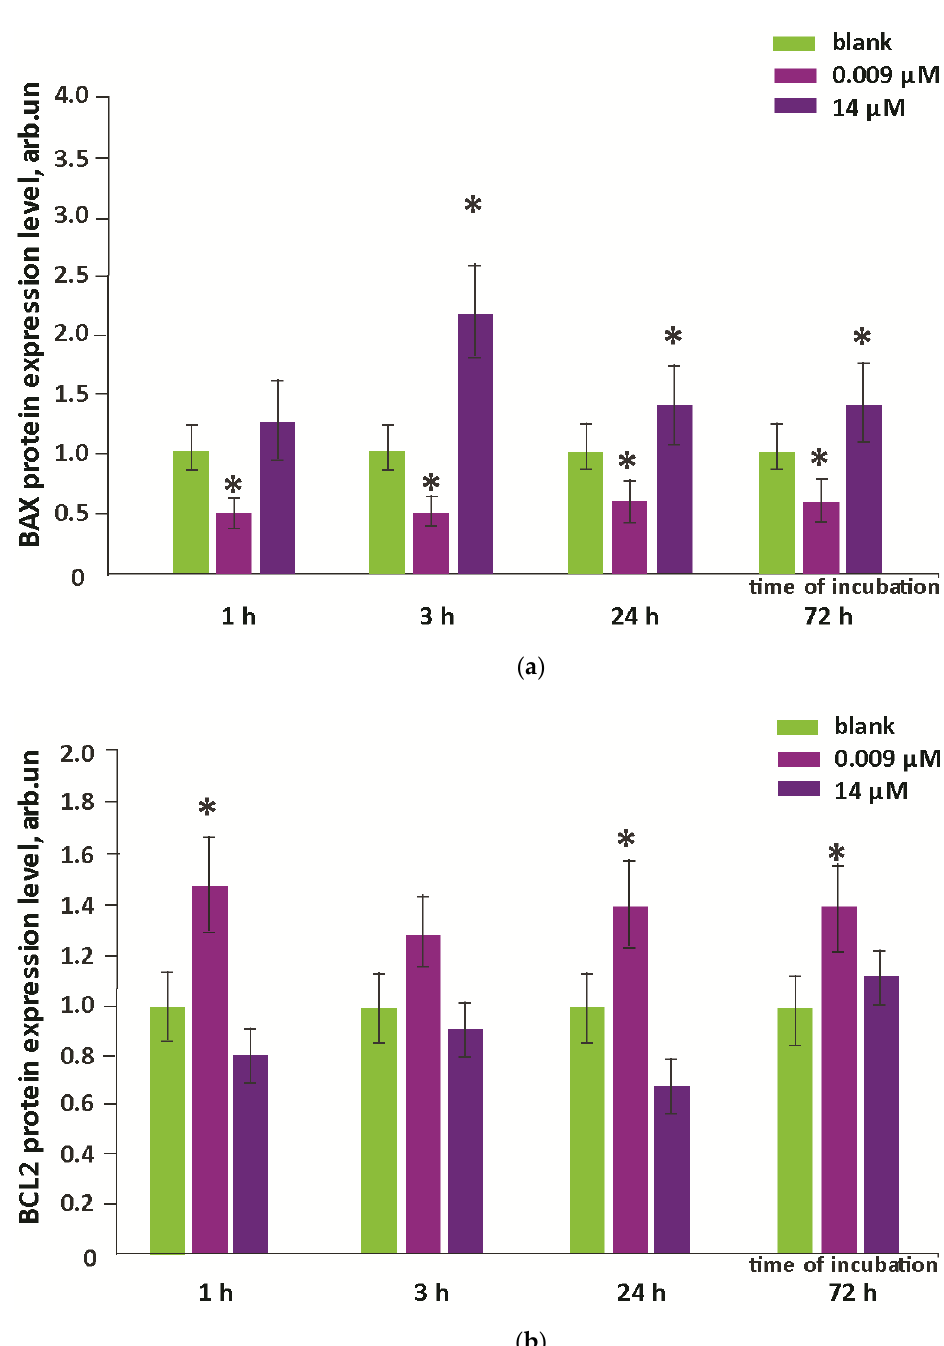
Figure 10. Expression of BAX ( a ) and BCL2 ( b ) proteins in HELF cells treated with F1 related to the control values (cells cultured without the fullerene). Significant differences with the control by the Mann-Whitney test ( p < 0.01) are denoted by “*”.